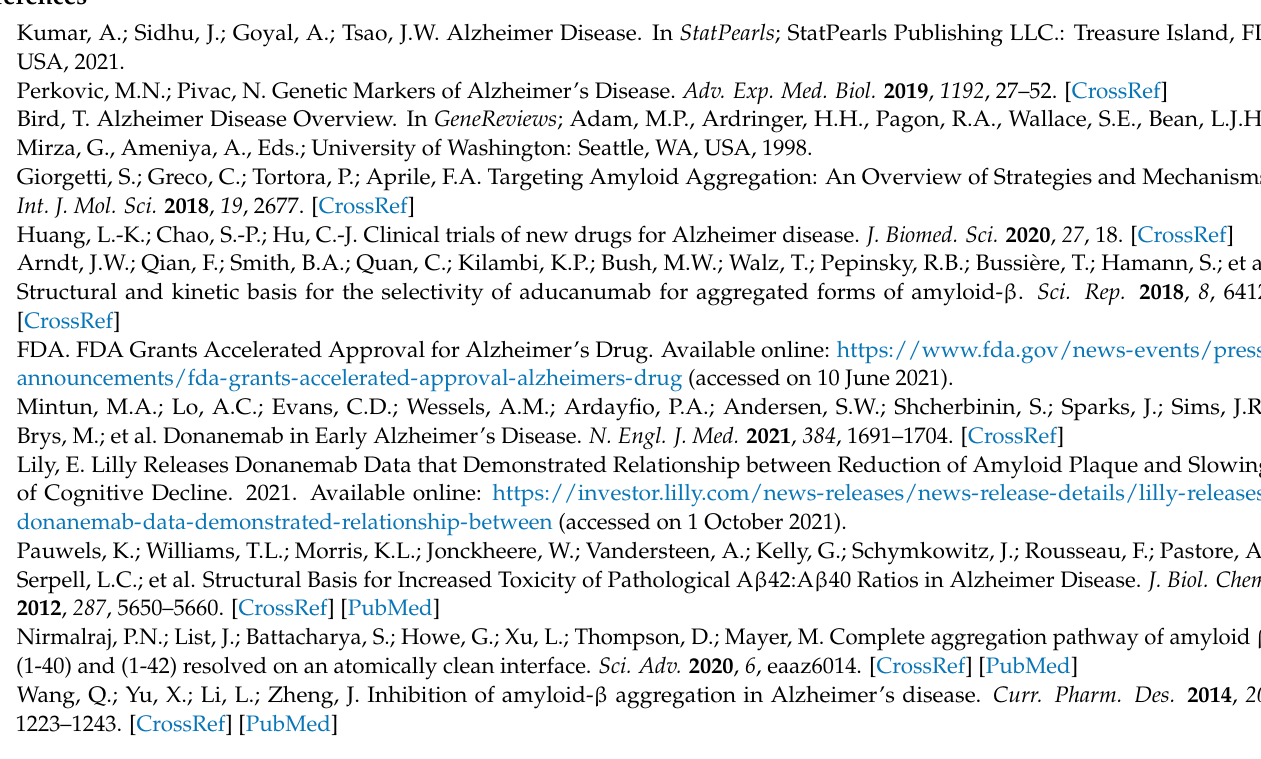
Variant by Disease, Figure S4: Results of Ranking Entire Data Set by Disease, Figure S5: Results of Ranking Entire Data Set by Mutation, Figure S6: Results of Ranking by Results Based on Average Age of